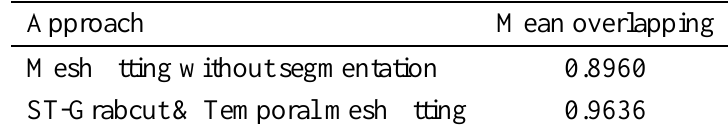
Table 2. AAM mesh fitting on original images and segmented images of the cVSG corpus.